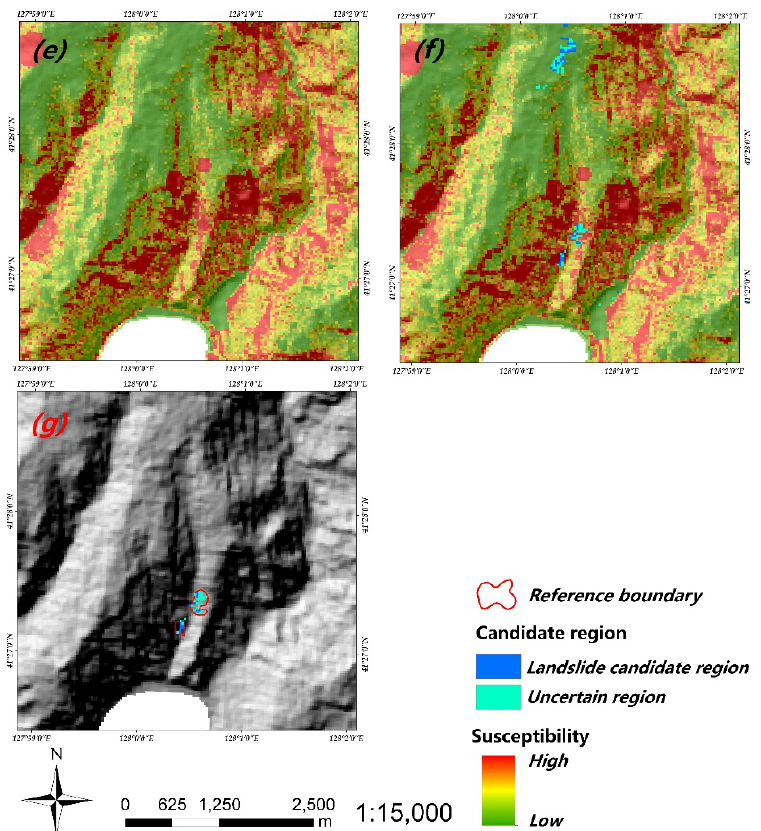
Figure 10. Landslide identification results in sub-area A. ( a ) Pre-event images; ( b ) post-event images; ( c ) difference image; ( d ) thresholding results; ( e ) susceptibility results; ( f ) overlapping; ( g ) final results. Different colors were assigned to the pixels inside the two landslide reference boundaries to clarify the results, assigned dark green color to α region and assigned light green color to β region, while pixels outside the boundary were colored black (Figure 11a). α and β regions are the code name of two landslide regions occurred in this sub-area.